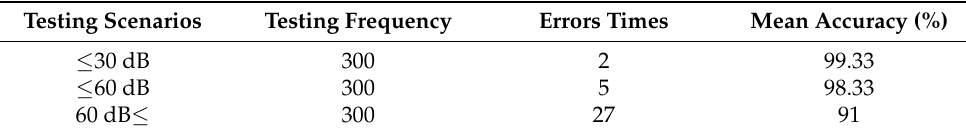
Table 3. Speech recognition test results.